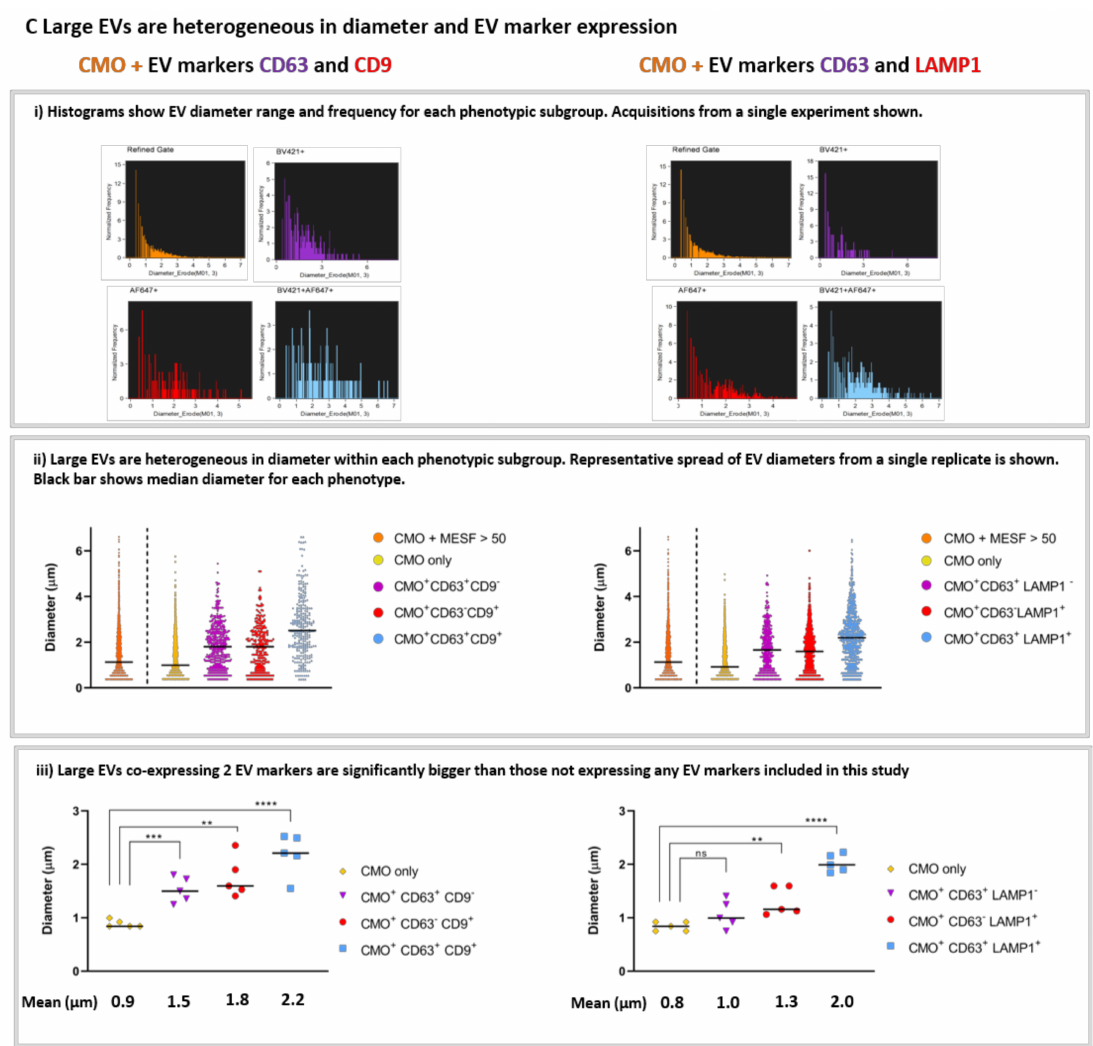
Figure 6. The ISX can accurately assign diameter to large EVs and facilitate individual event analyses to phenotype heterogeneous EV populations. ( A ) The median diameter of CMO + EVs from UW228-2 cells was comparable across 10 samples. The erode mask was applied to the bright field images of those EVs which were included in the CMO + > MESF 50 gate. The diameter of individual events within this gate was exported from IDEAS into PRISM for analysis. This figure shows a median diameter (represented by the black bar) of 922–1129 nm across the 10 samples and visualises the broad size range within each sample. (**** p > 0.0001 Kruskal-Wallis test). ( B ) The fluorescence intensity of the CMO was proportional to EV diameter. Bivariate plots showing CMO intensity against diameter consistently demonstrates a proportional relationship between EV size and intensity of the membrane label across samples run in triplicate experiments. 2 representative samples shown. (Regression analysis p < 0.0001). ( C ) Comparison of EV phenotypes across triplicate experiments. Individual histograms displaying EV diameter for each phenotype demonstrated di ff erential size ranges according to EV marker(s) expression (i a and i b). In each case, those labelled with CMO only and not expressing either CD63, CD9 or LAMP1 have a smaller median diameter compared with EVs expressing CD63 and / or CD9 or LAMP1 (ii a and ii b). In both cases, those EVs co-expressing both CD63 with CD9 (iii a) or CD63 with LAMP1 (iii b) are significantly larger than CMO only. (** p < 0.005, *** p < 0.0004, **** p <